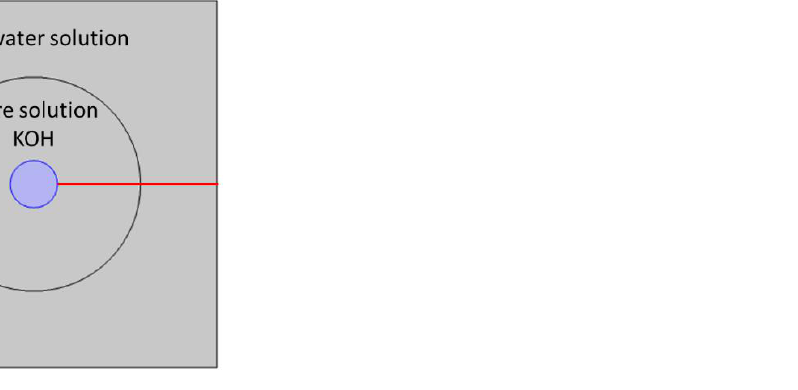
Figure 12. Model geometry — mortar sample of cylindrical geometry with an iron rod inside im- mersed in NaCl water solution. The results in Figures 13 – 18 will be presented along the red line.